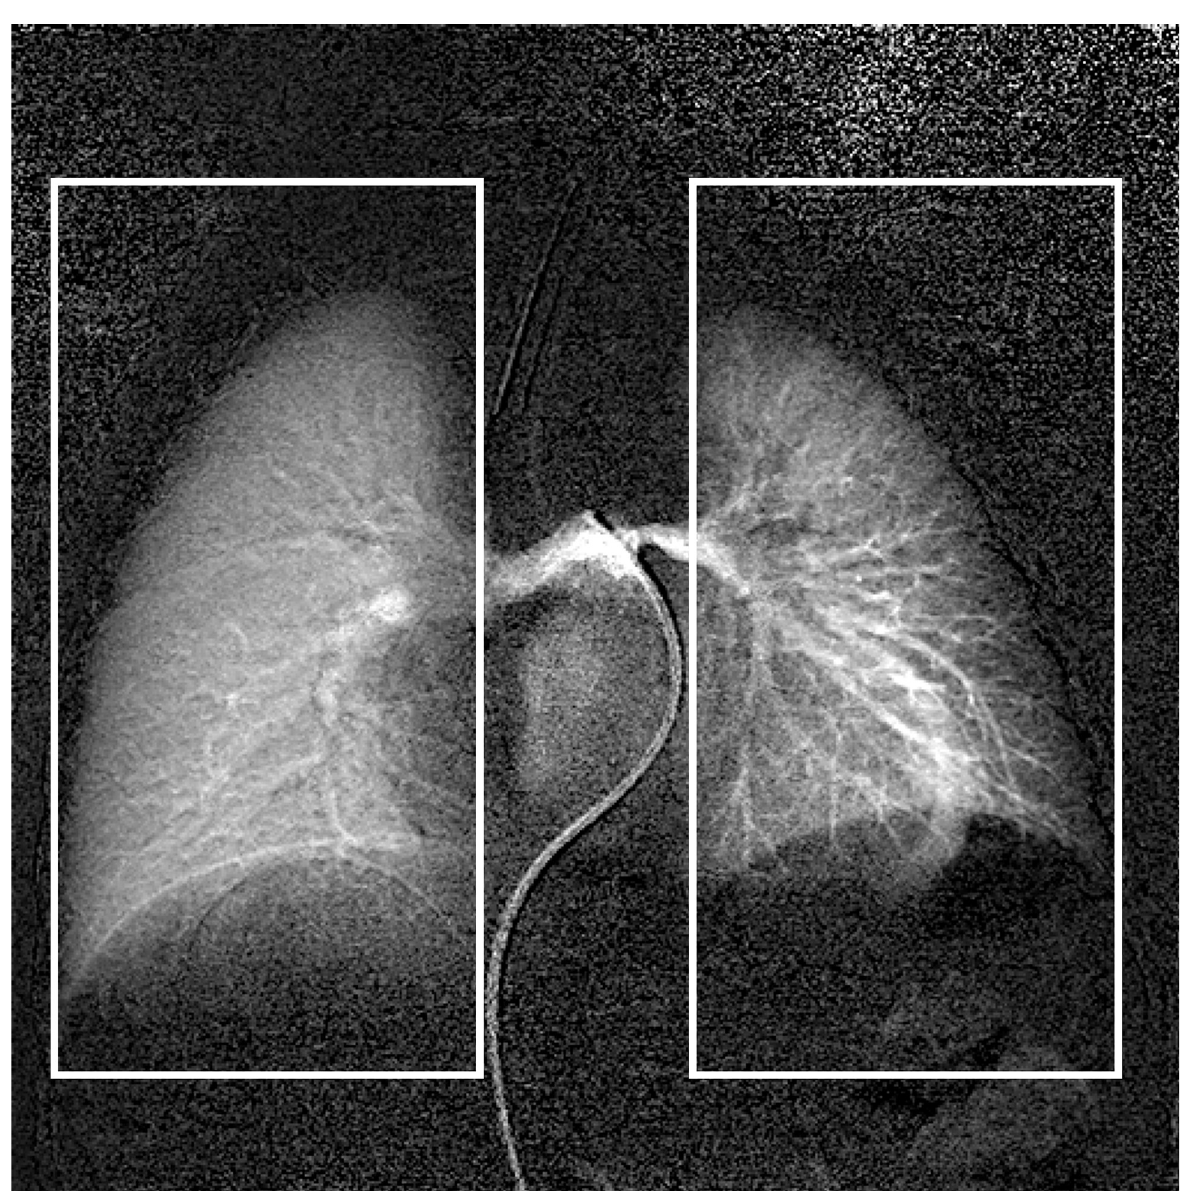
Fig 3. ROI establishment for measurement for each lung. Each lung field should be covered when data acquisition for calculating pulmonary blood distribution is performed by angiography as described in the text.